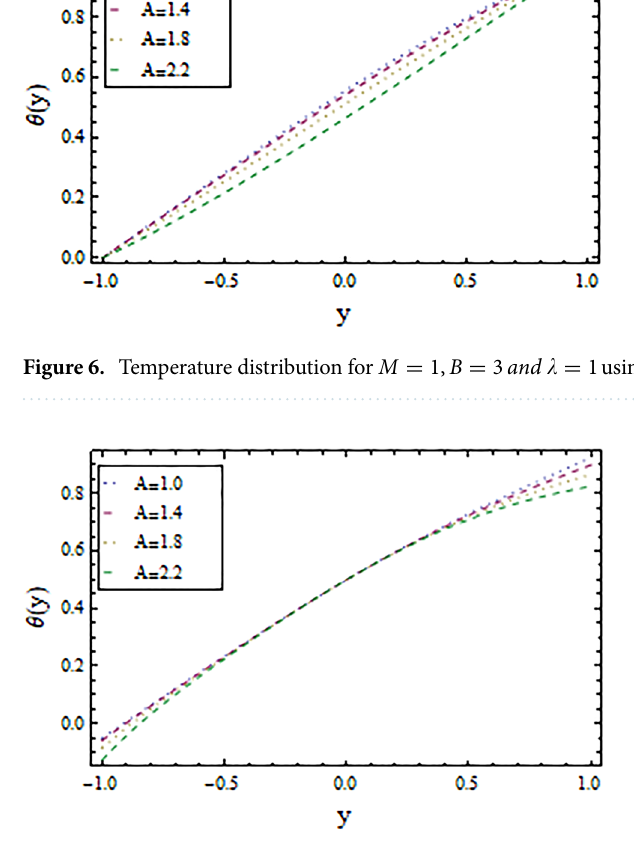
Figure 7. Temperature distribution for M = 1, B = 3 and (cid:31) = 1 using NIM.